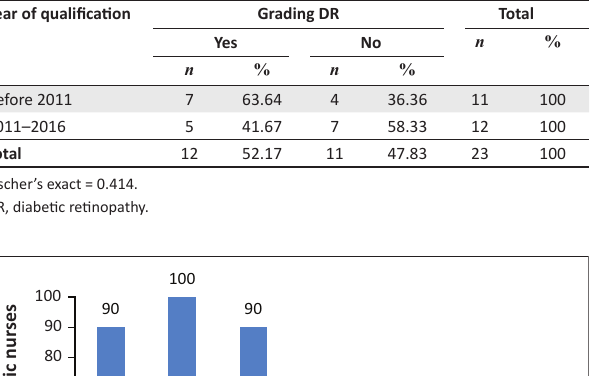
TABLE 3: Association between year of qualification of optometrists and grading diabetic retinopathy.